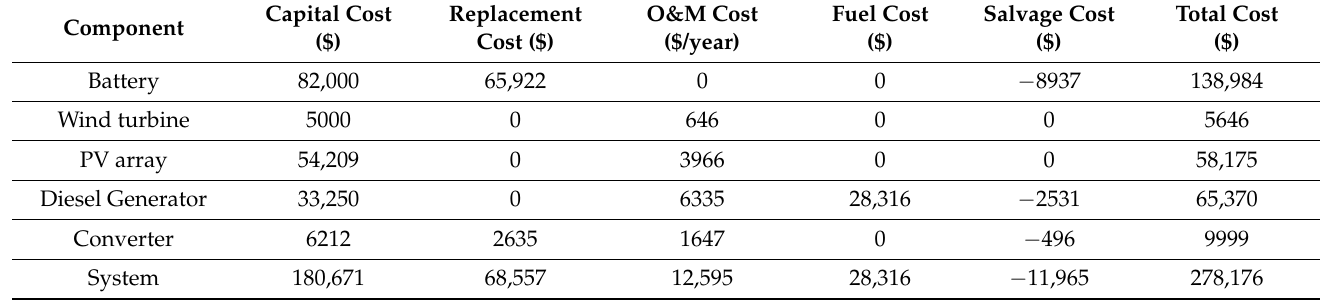
Table 7. Component-wise cost summary of the low cost PV-Wind-BSS-DG hybrid configuration.